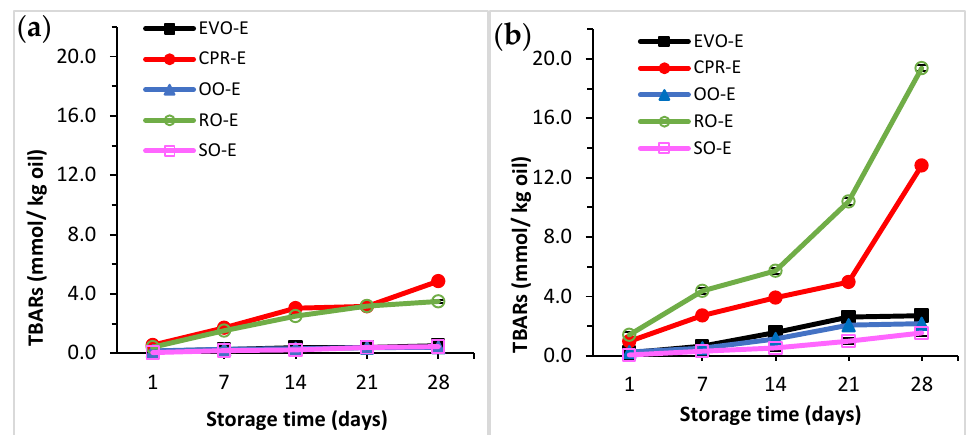
Figure 3. TBARS of conventional emulsions during storage time at ( a ) 25 °C and ( b ) 40 °C. Conven- tional emulsions (-E) prepared with the different oils: extra virgin olive oil (EVO-E), cold-pressed rapeseed oil (CPR-E), olive oil (OO-E), rapeseed oil (RO-E), sunflower oil (SO-E).